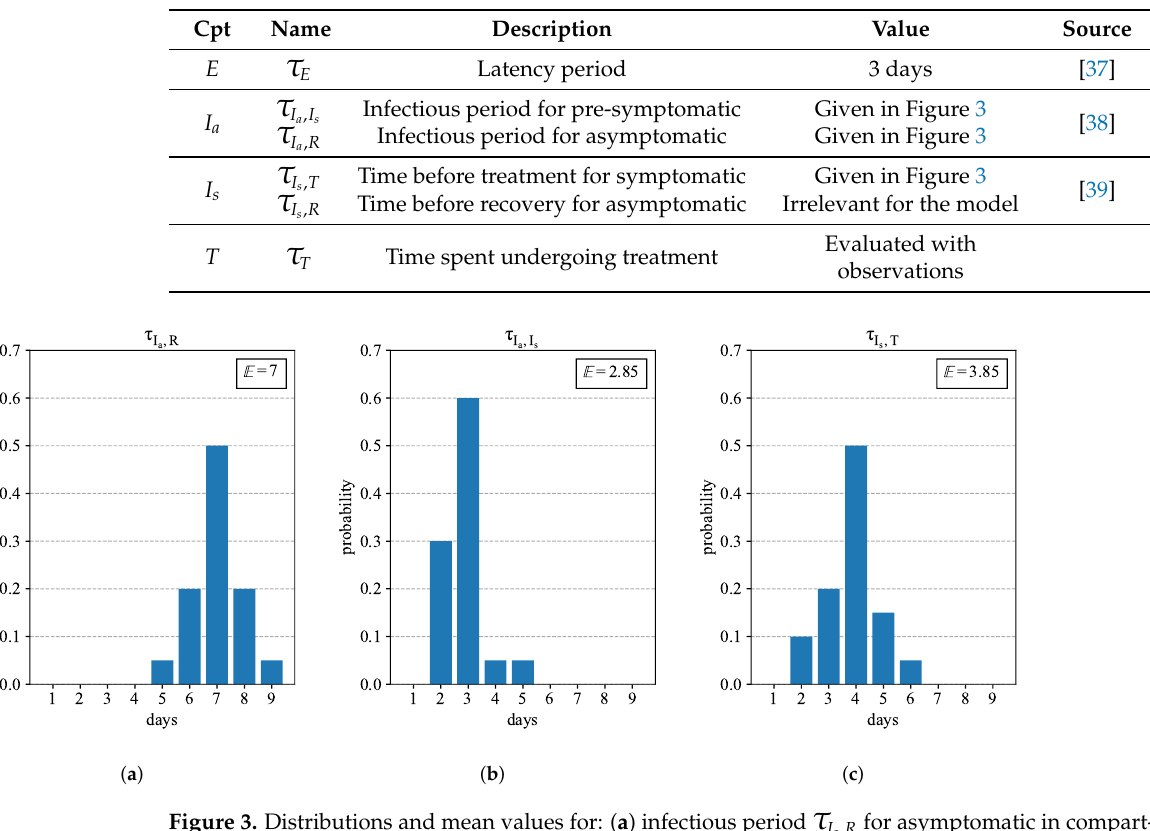
Table 2. Time spent in compartments (Cpt).